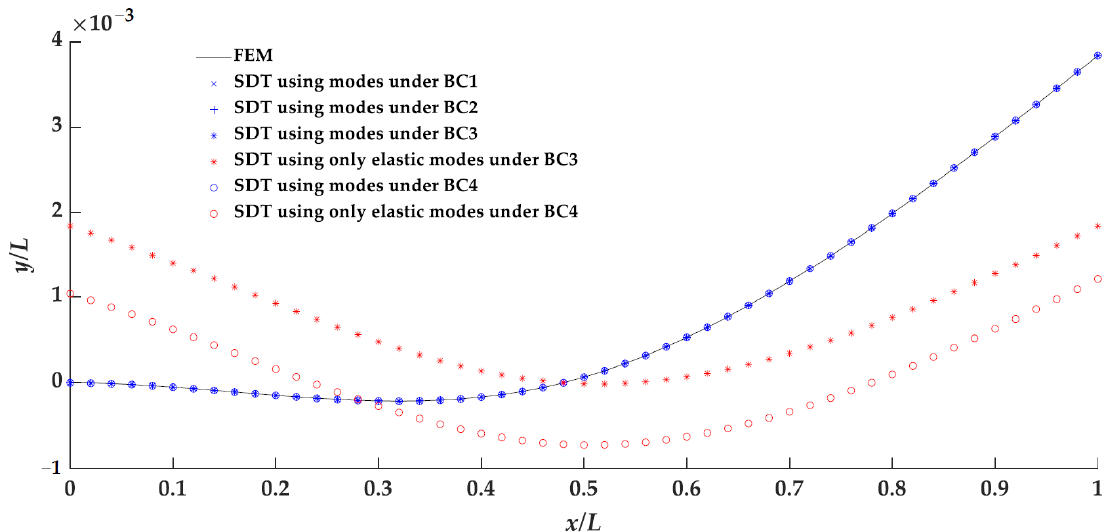
Figure 7. Comparisons of calculated displacements from FEM and those obtained from SDT.